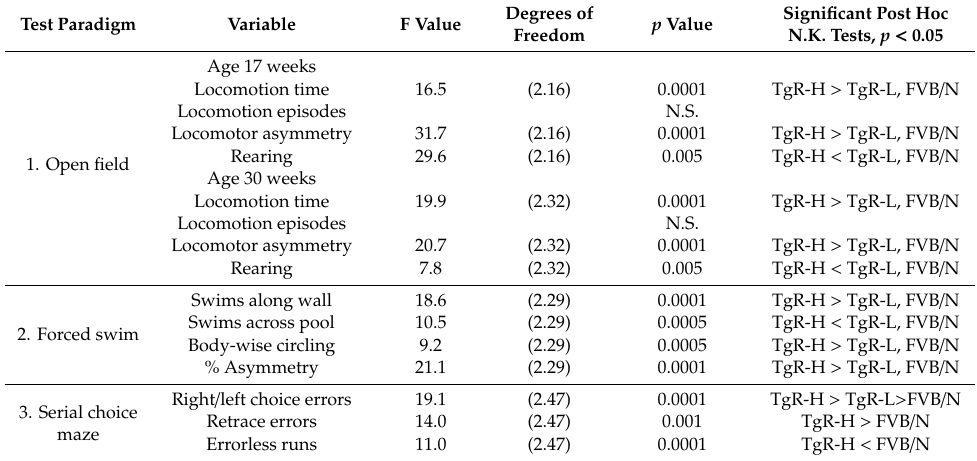
Table 2. The behavioral paradigm. Behavioral tests comparing naive FVB / N, TgR-L and TgR-H mice. Test Paradigm Variable F Value